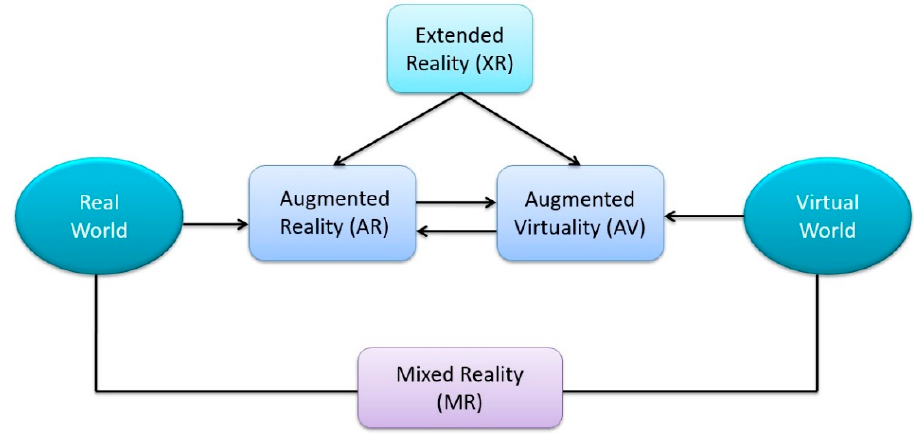
Figure 1. Mixed Reality continuum.